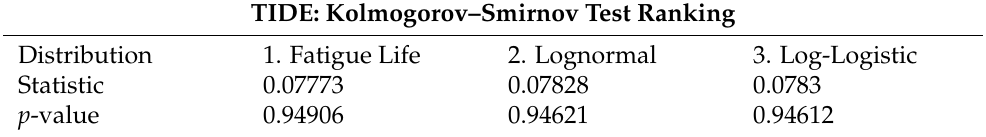
Table 9. Kolmogorov–Smirnov test values for the three best fitted two-parameter distributions for the tide influence.